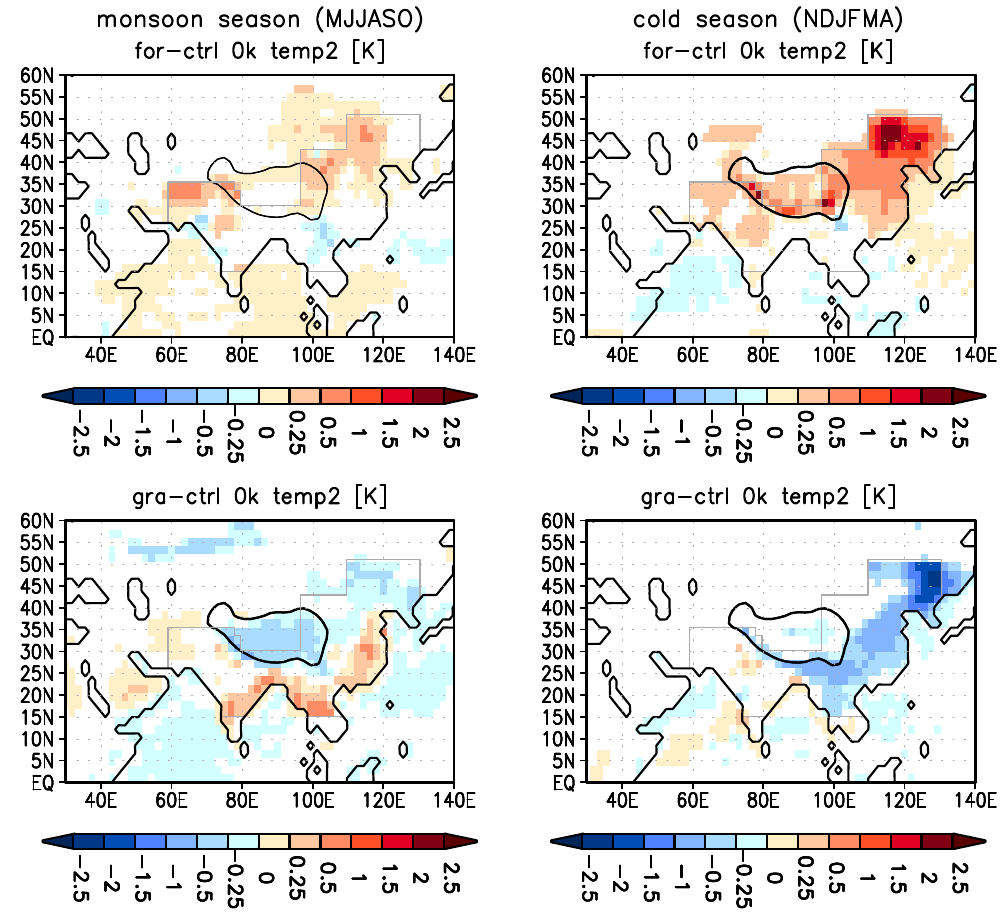
Fig. 4. Simulated near-surface air temperature (in 2m height) change between the afforestation (for) or deforestation (gra) experiment and the control run (ctrl), averaged over the monsoon season (left panel) and the dry/cold season (right panel). The monsoon season lasts from May to October, the dry/cold season contains the month from November to April. Values are given in K. Only values exceeding the 95%-significance (t-test) are